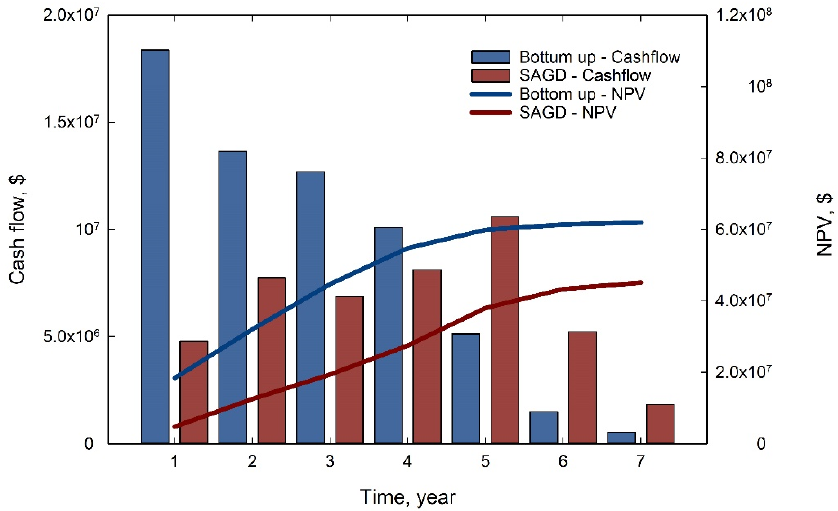
Figure 9. Comparison of cash flow and NPV results between SAGD and bottom ‐ up assisted pressure drive processes indicating the bottom ‐ up assisted pressure improves the economics.